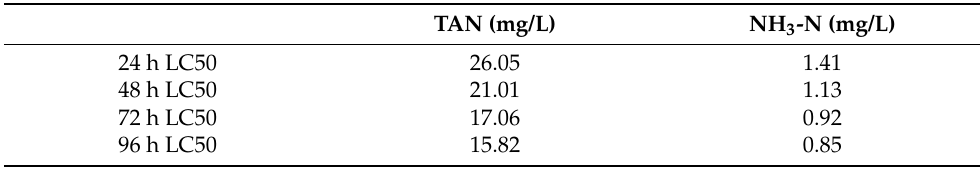
Table 3. LC50 of bighead carp exposed to